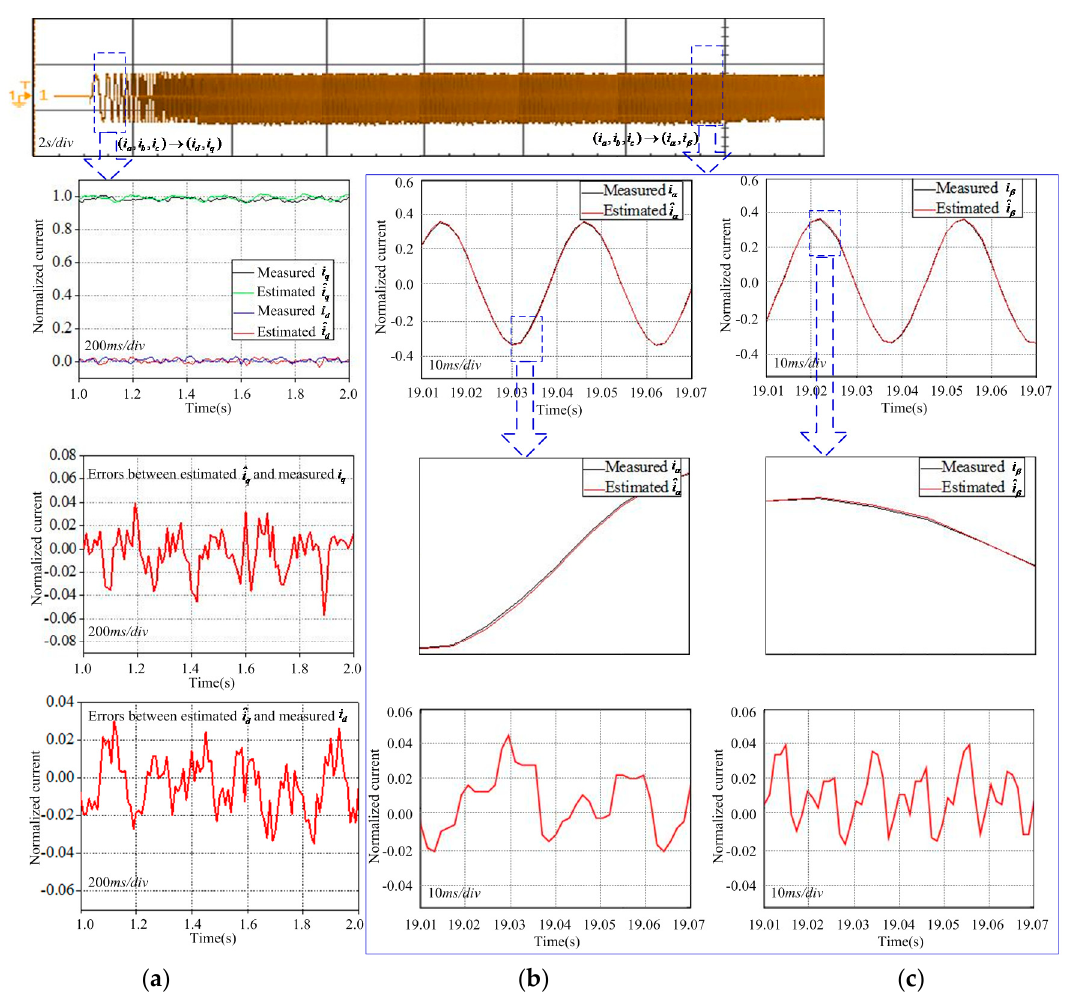
Figure 12. Comparison for the output current of the observer and the measured current ( a ) Comparison for the output current of the start-up estimation algorithm and the measured current ( b ) and ( c ) Comparison for the output current of the operation estimation algorithm and the measured current.